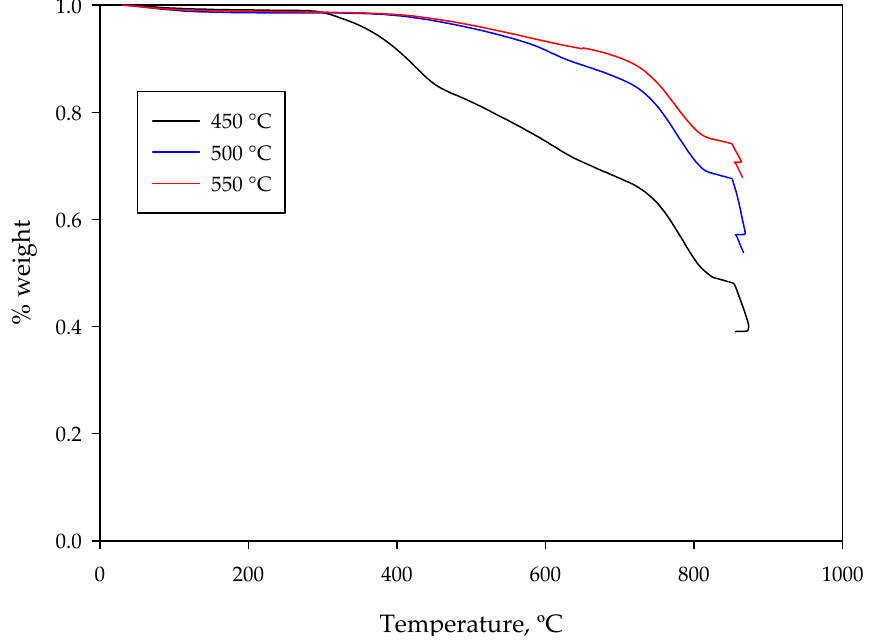
Figure 1. Thermogravimetric curves of the solids obtained by pyrolysis of the non-recyclable mixed plastics from municipal solid waste at different temperatures.